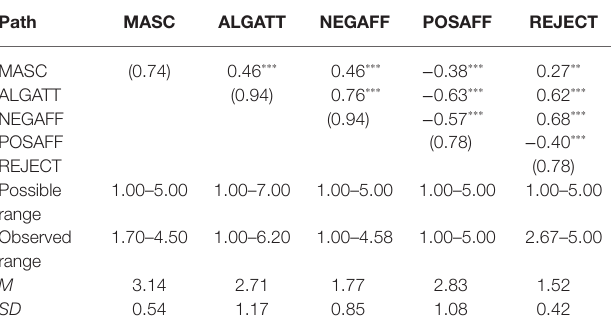
TABLE 1 | Bivariate correlations and scale